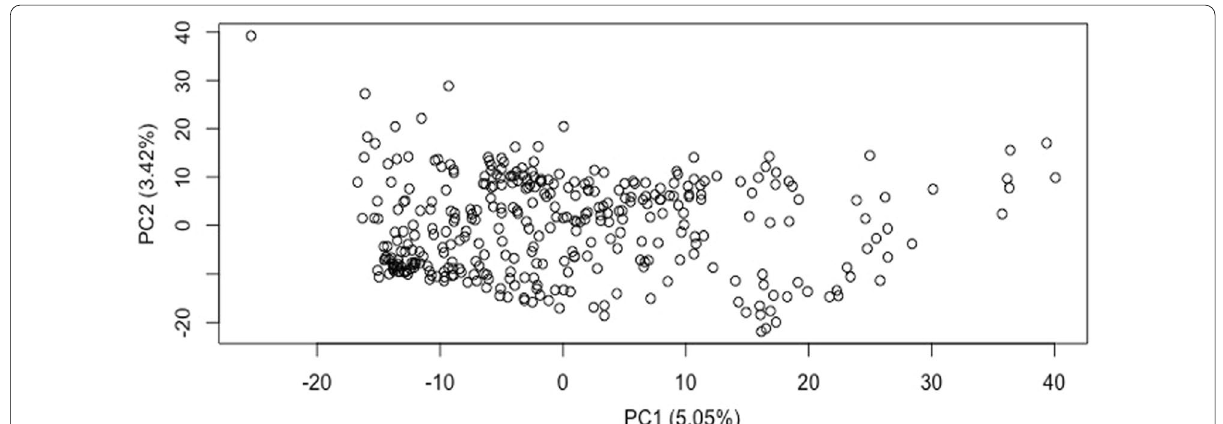
Fig. 2 PCA plot generated from marker data of 346 accessions of O. rufipogon population from 16 different countries